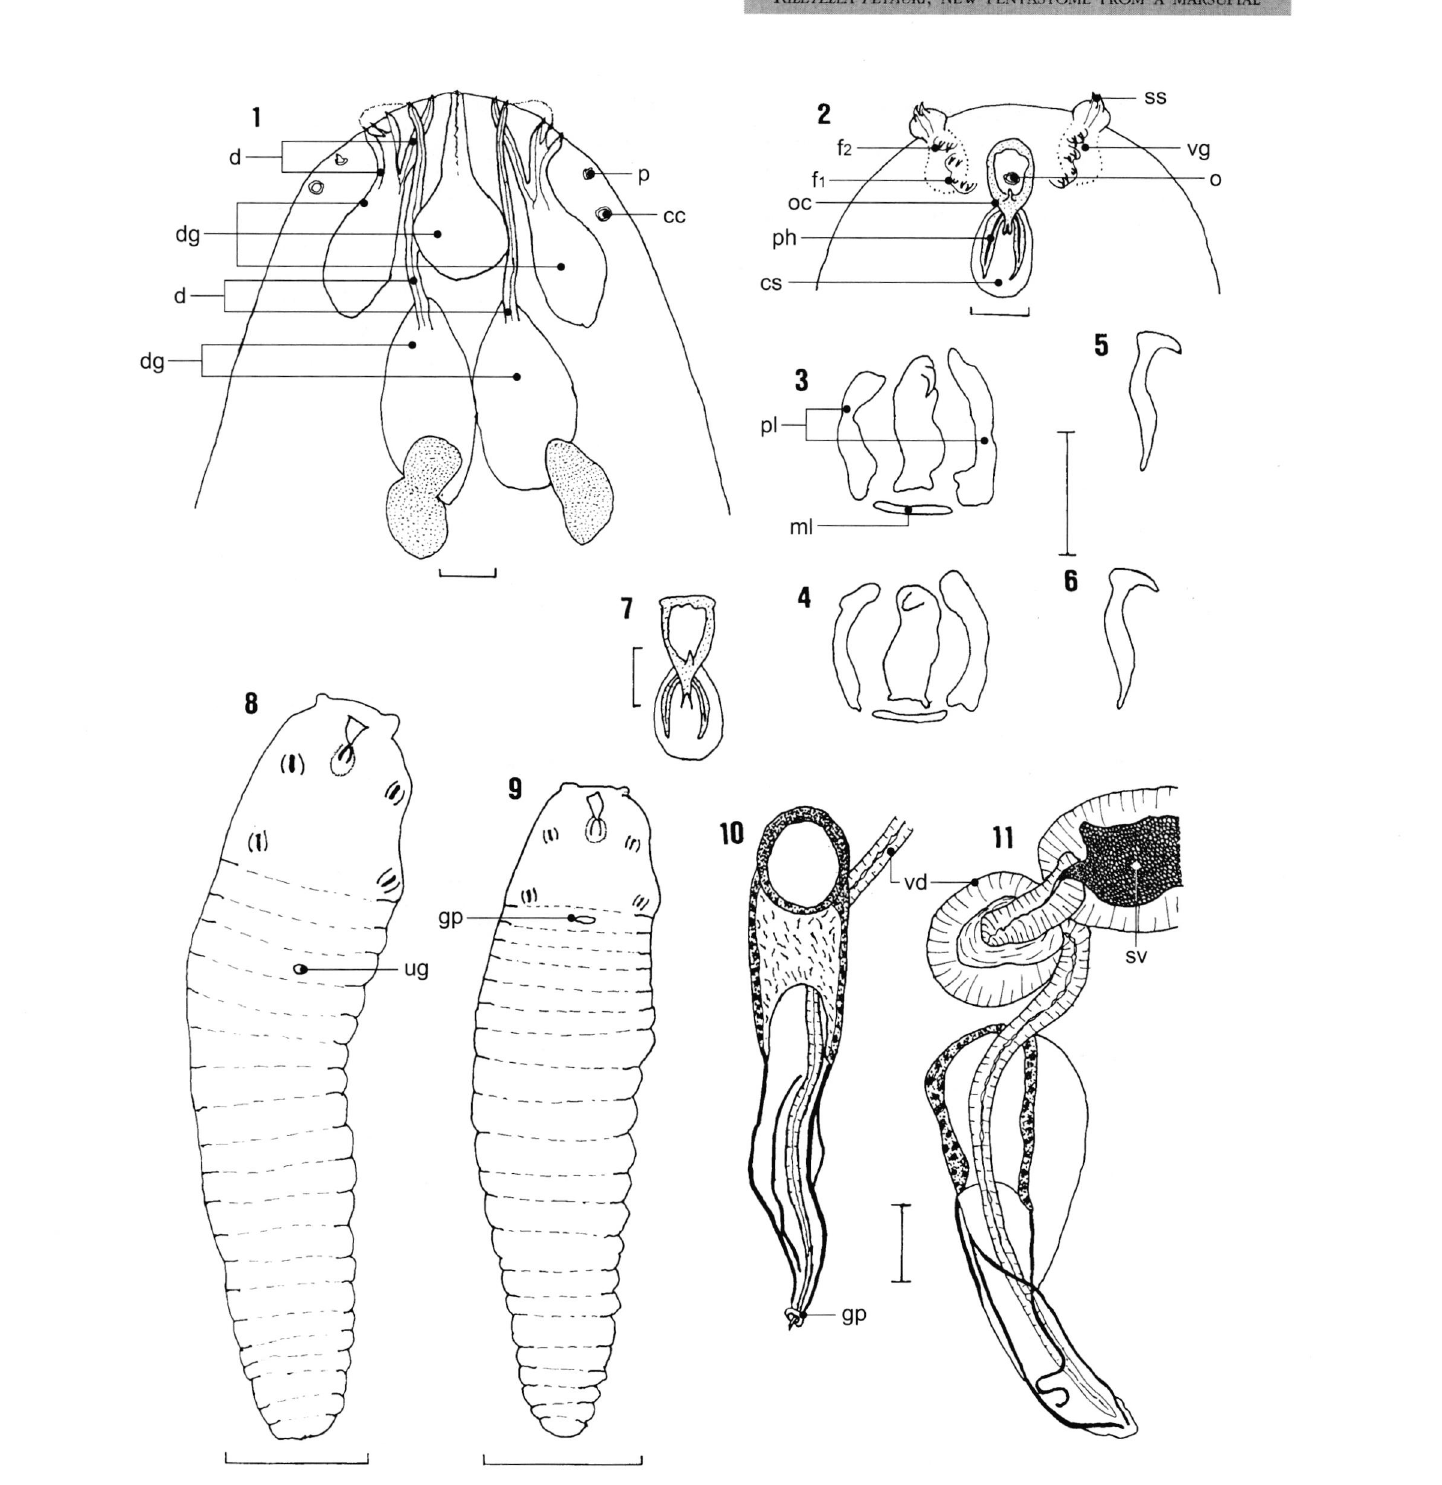
Figs. 1-11. - Rileyella petauri gen. nov., sp. nov. 1. Cephalothorax illustrating dorsal glands (dg), efferent ducts (d) leading to exterior and terminating in sensillae, tegumental chloride cells (cc) and papillae (p) dorsal view, bar - 20 µm. 2. Cephalothorax illustrating tiny oral opening (o), oral cadre (oc), pharynx (ph), cresentric structure (cs) of unknown function, ventral glands (vg) terminating in paired, seta like structures (ss). anterior frontal papilla with two large sensillae (f,) and partially bilobed posterior frontal papilla with sensillae (f,), ventral view, bar = 20 µm. 3. Anterior hook with median podial lobe (ml) and lateral parapodial lobes (pl), ventral view, bar = 20 µm. 4. Posterior hook with median podial and lateral parapodial lobes, ventral view, bar = 20 µm. 5. Anterior hook, lateral view, bar = 20 µm. 6. Posterior hook, lateral view, bar = 20 µm . 7. Oral cadre, pharynx and crescentric structure of unknown funtion, dorsal view, bar = 20 µm . 8. Female body with urogenital opening (ug) on annulus 3, ventral view, bar = 200 µm. 9. Male body with genital pore (gp) on annulus 1, ventral view, bar = 200 µm. 10. Male copulatory spicule, vas deferens (vd) and showing ornamentation of proximal portion of spicule and distal cirrus protruding through genital pore (gp), dorsal view, bar - 20 pm. 11. Male copulatory spicule, vas deferens (vd) and seminal vesicle (sv) containing sperm, ventral view, bar - 20 µm